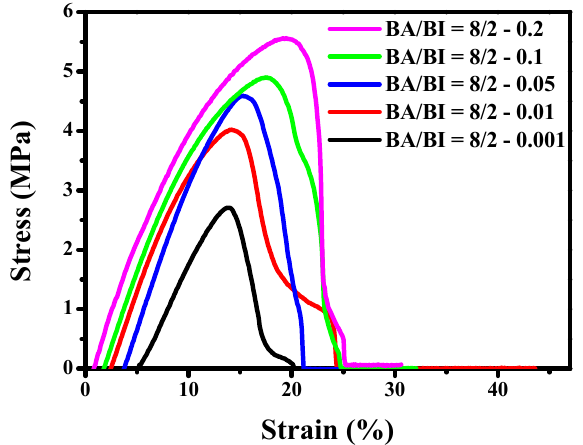
Figure 16. The stress–strain curves of the PBABI copolyesters at different concentrations of EDTA.